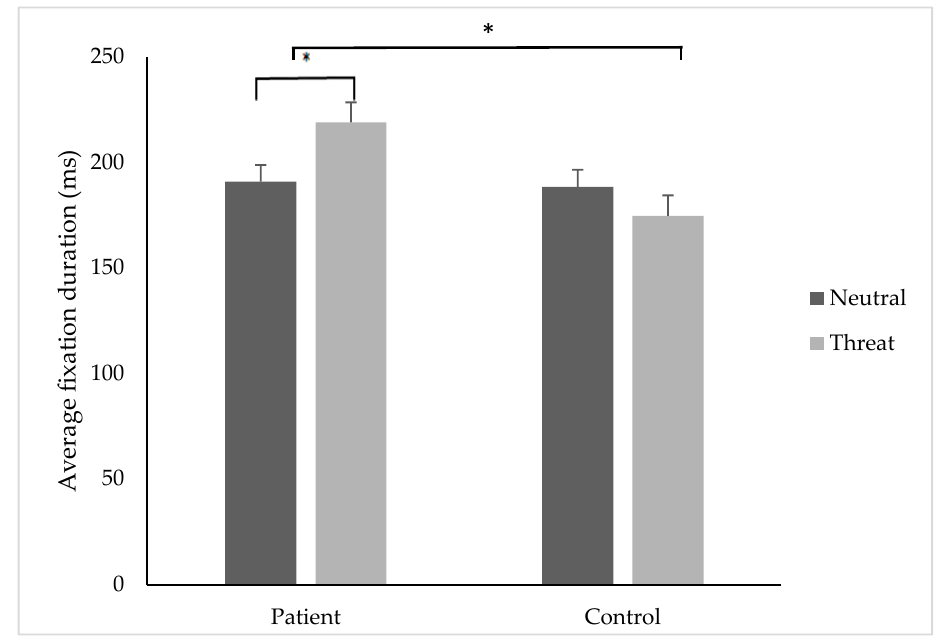
Figure 4. The average fixation (ms) duration (±SE) to threatening and neutral stimuli for the patient and control group. * indicates p < 0.05.